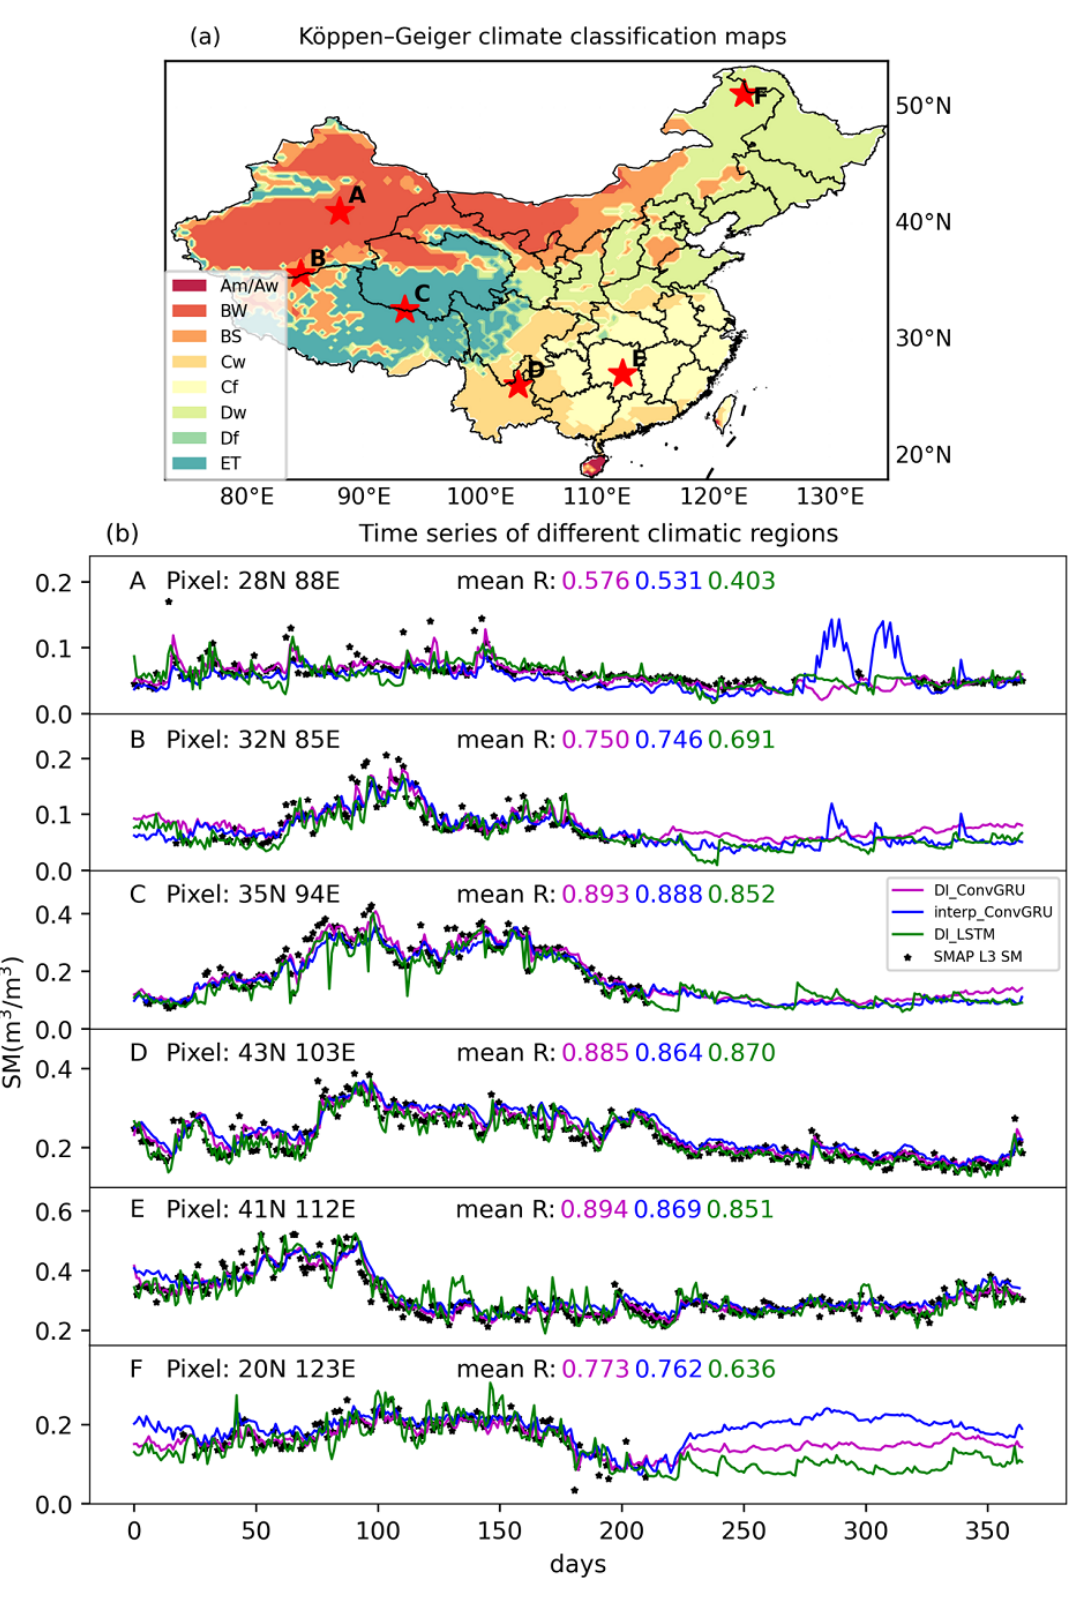
Figure 7. ( a ) Randomly selected pixel locations in the Köppen–Geiger climate region map of China and ( b ) Forecast of SM time series in different climatic regions by different models (from 1 April 2017 to 31 March 2018).